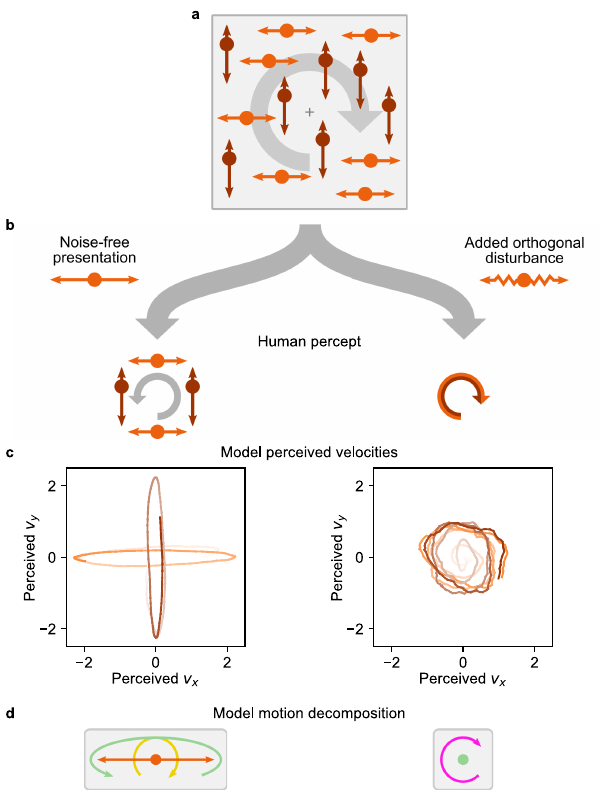
Fig.5|Noise-dependentperceptualchangesformotionintegrationofspatially distributed stimuli. a In the motion illusion from Lorenceau 42 , a vertically and a horizontally oscillating group of dots maintain a 90°-phase shift consistent with global clockwise rotation (indicated as gray arrow). b The noise-free stimulus (left branch) evokes transparent motion with an additional counter-clockwise rotating percept in human observers. Adding motion noise by disturbing dot trajectoriesorthogonallytotheirgroup ’ soscillationaxis(rightbranch;modeledby ) fl ips the percept to a single coherent rotation of increased observation noise σ 2 obs all dots in clockwise direction. c The model ’ s perceived velocities in both stimulus conditions (time = color gradient from low to high contrast; t ≤ 2s in noise-free condition; t ≤ 5s in noisy condition). For visual clarity, perceived velocities have been smoothed with a 200ms box fi lter for plotting. d Illustration of the model ’ s inferred motion decomposition. For noise-free stimuli, clockwise rotating self- motion is compensated by counter-clockwise rotating group motion (sketched hereforthe horizontalgroup).Withmotionnoise,onlyasingle,clockwiserotating shared motion component is inferred for all dots. Source data are provided as a Source Data fi